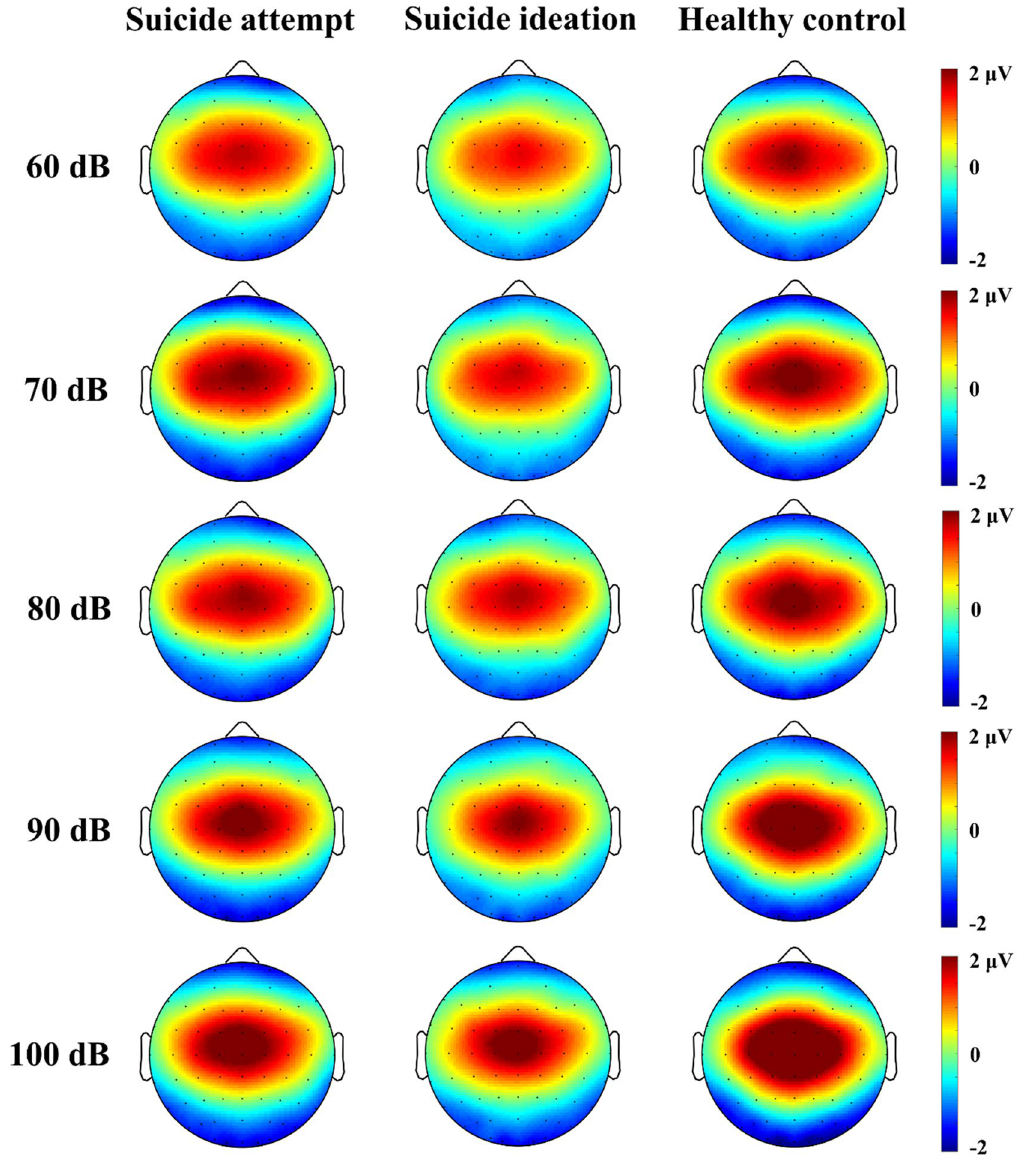
Figure 2. Topographic maps of P2 component minus N1 component for each auditory stimulus in MDD patients with suicide attempts and suicide ideation, and healthy